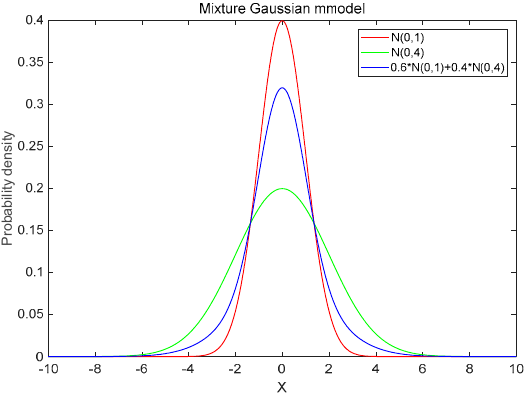
Figure 13. Probability model of Gaussian mixture noise. Table 4. Performance of the different filter algorithms with different parameters in the linear/mixture Gaussian system.